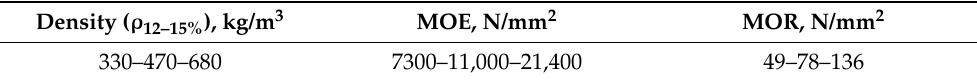
Table 1. Reference values (min-mean-max) for the density, MOE, and MOR of spruce wood [6]. Density ( ρ 12–15% ), kg/m